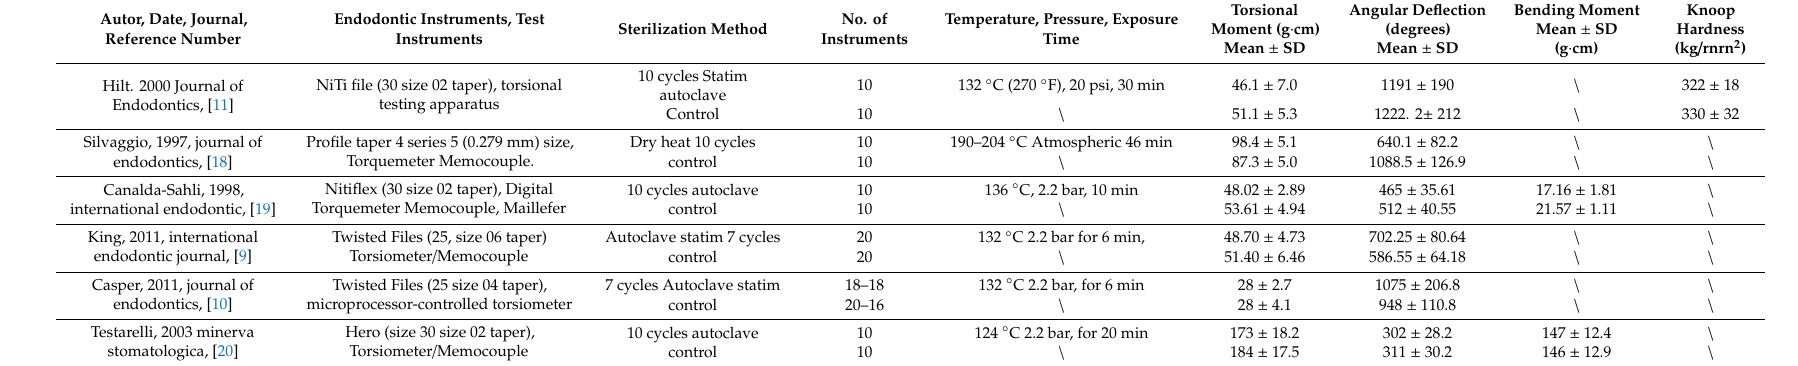
Table 3. Extracted data from selected studies (primary outcome and secondary outcome).